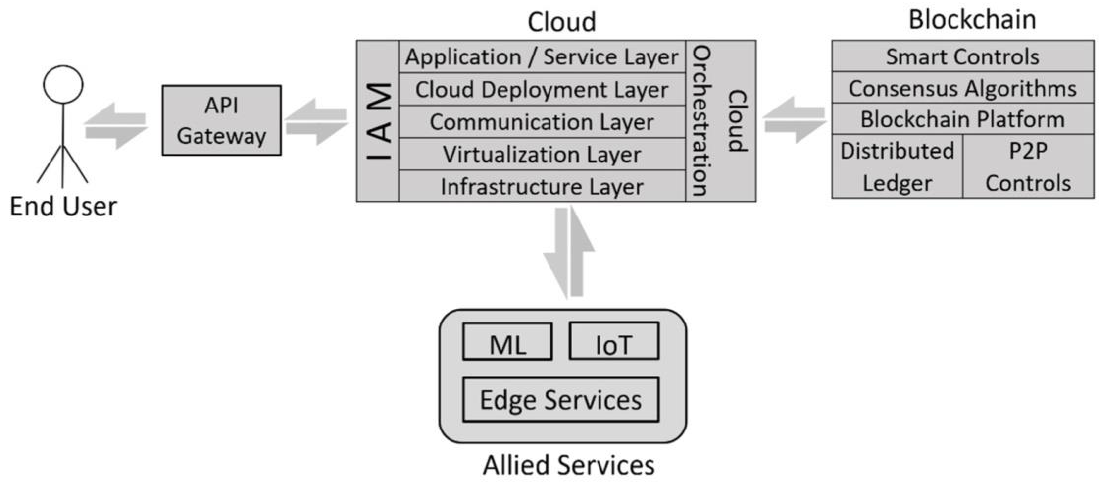
Figure 3. The architecture of cloud integrated with blockchain [20,21].